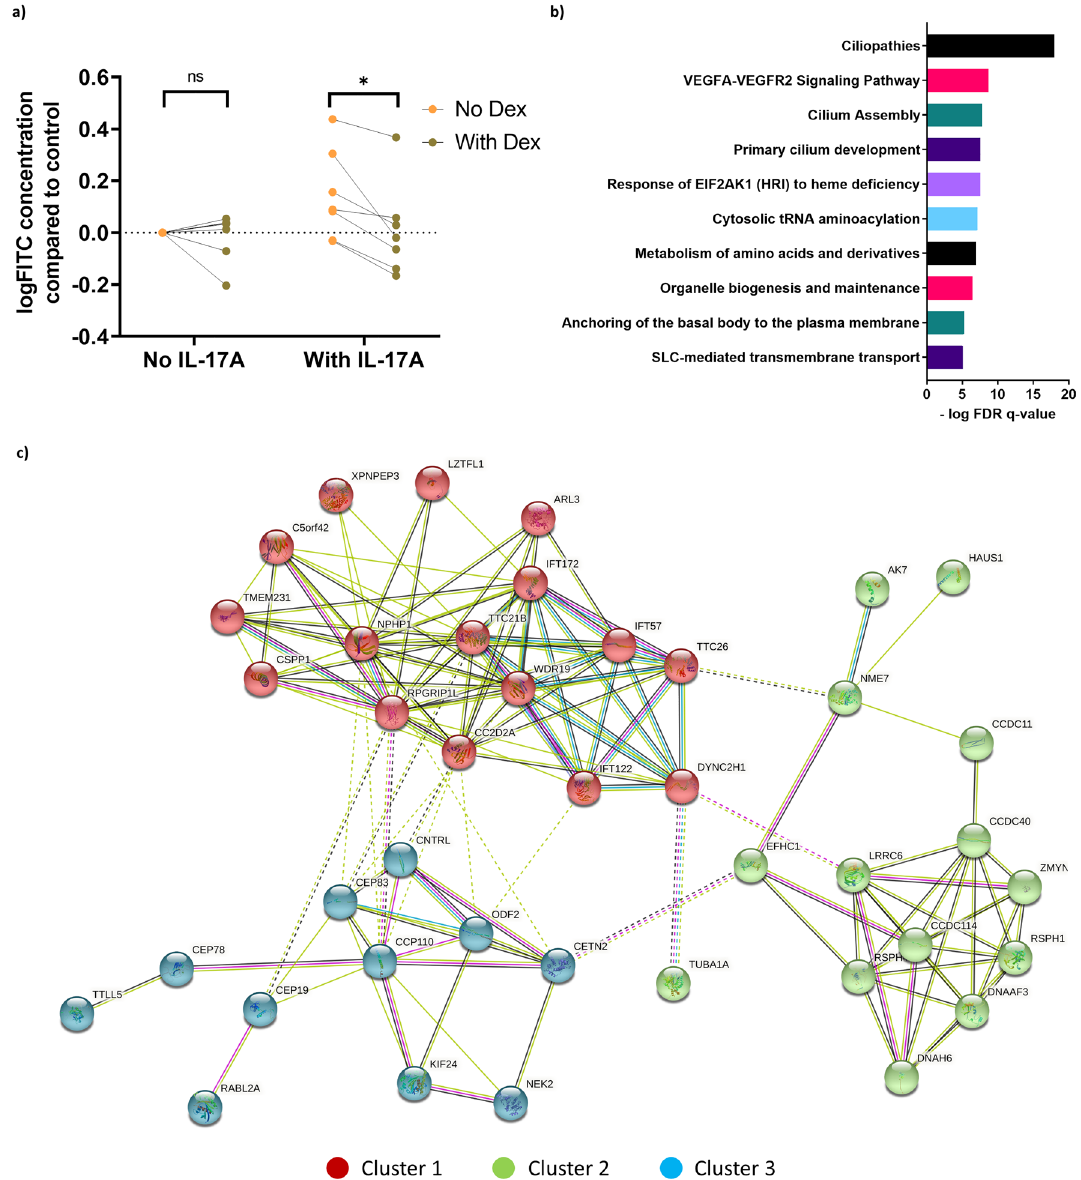
Figure 7. Dexamethasone (Dex) reverses IL-17A-induced epithelial barrier disruption in human airway epithelial cells (hAECs). hAECs were cultured and differentiated at an air liquid interface (ALI) and exposed to IL-17A (10 ng/ml) with or without dexamethasone (10 nM) for 14 days. Epithelial barrier function was assessed by permeability to fluorescein isothiocyanate-dextran (FITC-dextran) after 2 weeks incubation with IL-17A or dexamethasone of combination of both. FITC concentration was measured and calculated from fluorescence intensity. Data are from N = 7 donors ( a ). Gene expression was determined by bulk RNA sequencing and differentially expressed genes were analyzed. Statistically significant genes were used for pathway analysis (GSEA) and presented as top 10 most regulated pathways ( b ). String analysis (https:// string- db. org/) was done to the genes that are related to cilia function and development ( c ). Data represent means ± SEM. N = 4 donors. Statistical analyses were performed with paired one-way ANOVA and Tukey’s multiple comparison test, *p <